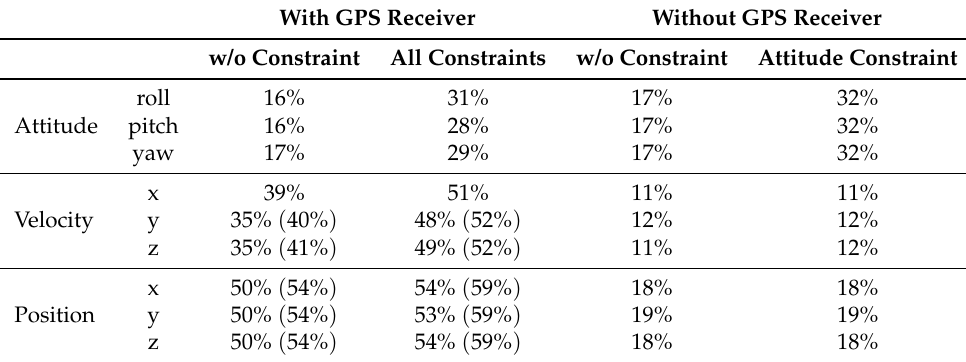
Figure 18. The attitude estimation error standard deviation obtained with the multi-INS fusion when all geometrical constraints are applied versus when only the relative attitude constraint is used. Table 2. Reduction of the estimation error standard deviations provided by the fusion of multiple INSs at the satellite injection (values in parentheses represent the maximum improvement when it does not occur at the satellite